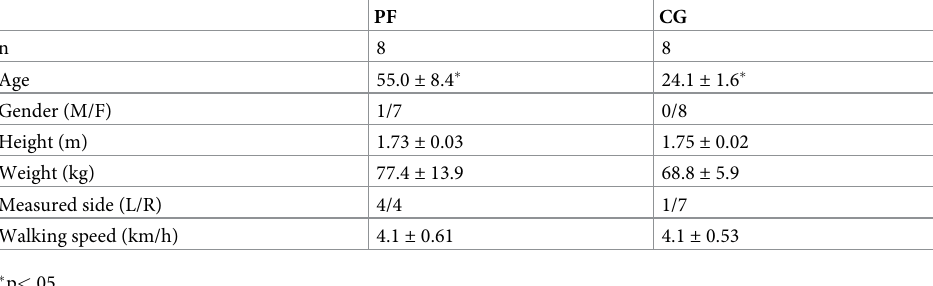
Table 1. Participant characteristics (mean ±